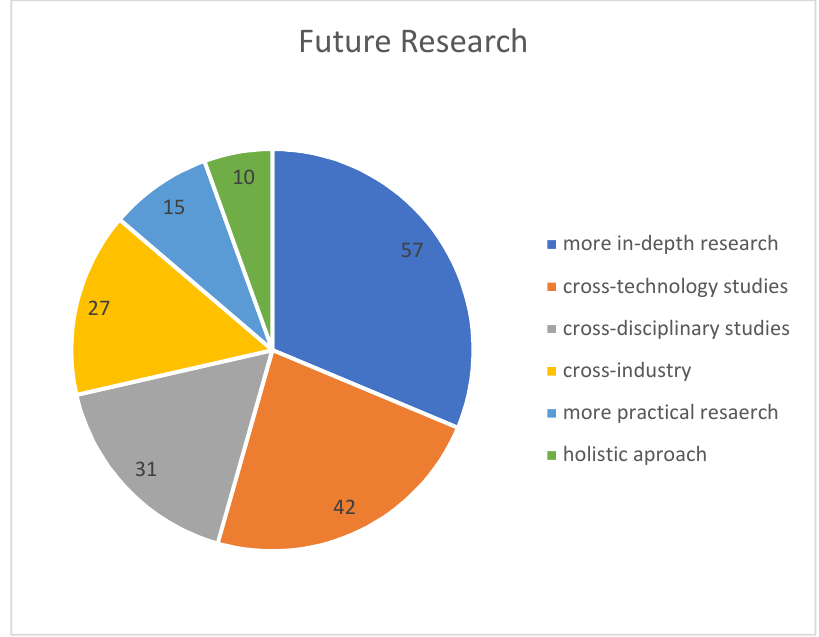
Figure 9. Overview of future research recommendations.